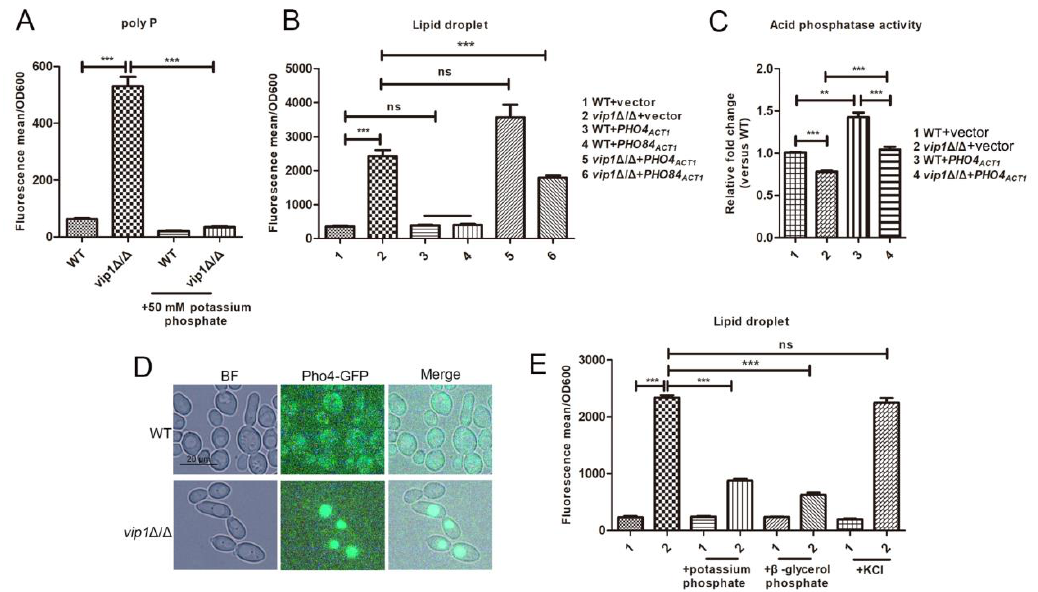
Figure 3. Knockout of vip1 in C. albicans results in decreased activity of the PHO pathway. ( A ) polyP content determination. The strain was grown in SC or SC medium supplemented with Pi, and the polyP content was determined. ( B ) LD content determination. ( C ) Acid phosphatase activity deter- mination. ( D ) The WT-Pho4-GFP and vip1 Δ/Δ -Pho4-GFP strains were grown in SC medium for 4 – 6 h, and the location of Pho4-GFP was observed by fluorescence microscopy (BX-53, Olympus, Japan). ( E ) Determining the LD content of vip1 Δ/Δ when grown i n SC or SC medium supplemented with Pi, β -glycerol phosphate or KCl. 1: WT, 2: vip1 Δ/Δ. ** p < 0.01, *** p < 0.001, ns: no significance.